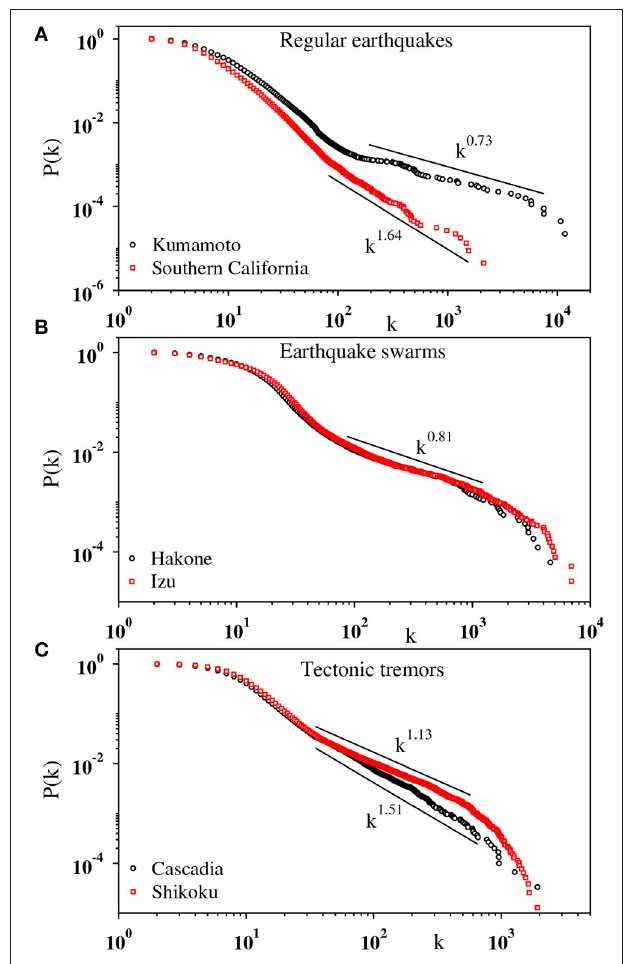
FIGURE 10 | Log-log plot of the cumulative degree distribution P ( k ) for the IET series of different types of earthquakes: (A) regular earthquakes in Kumamoto (black) and Southern California (red); (B) swarms in Hakone (black) and Izu (red); (C) tremors in Cascadia (black) and Shikoku (red). The slopes in the fitted region (solid line) are 0.73(8), 1.64(5), 0.81(9), 0.79(9), 1.51(5), and 1.13(5),